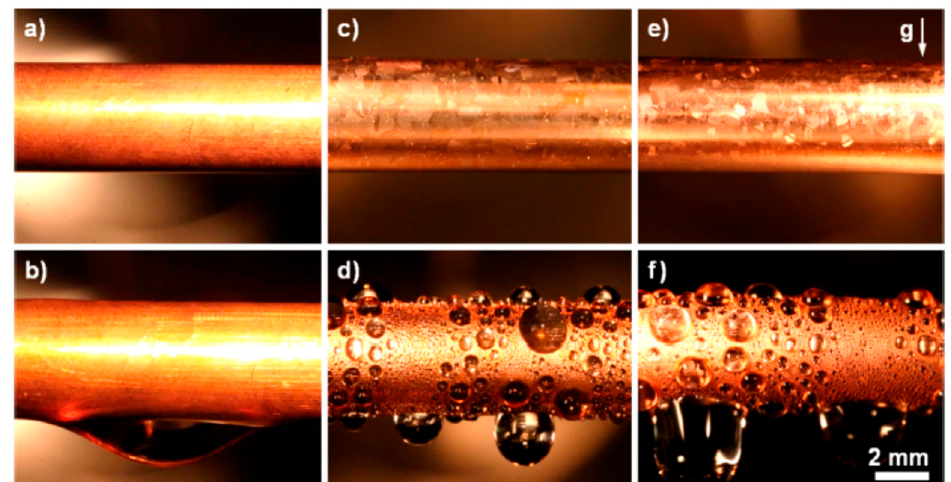
Figure 10. Cu tube ( a ) under vacuum and ( b ) showing FWC; graphene-coated Cu tube shows DWC with ( c , d ) low-pressure and ( e , f ) atmospheric-pressure CVD coatings [65]. Reprinted with permission from Ref. [65]. Copyright 2015 ACS Publications.